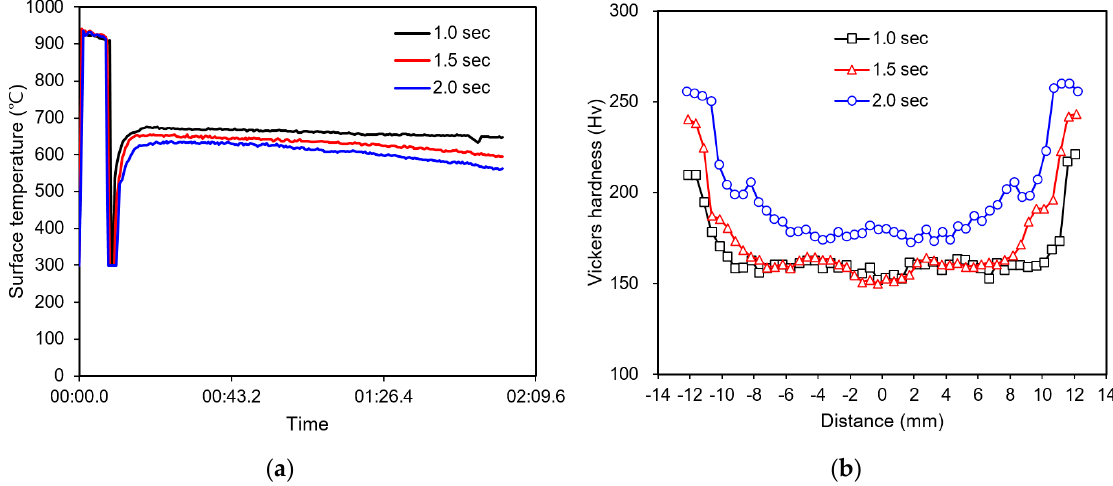
Figure 10. ( a ) Variation of temperature for cooling times of 1.0, 1.5, and 2.0 s; ( b ) measured Figure10. ( a )Variationoftemperatureforcoolingtimesof1.0, 1.5, and2.0s; ( b )measuredmicrohardness microhardness for the cooling times of 1.0, 1.5, and 2.0 s. for the cooling times of 1.0, 1.5, and 2.0